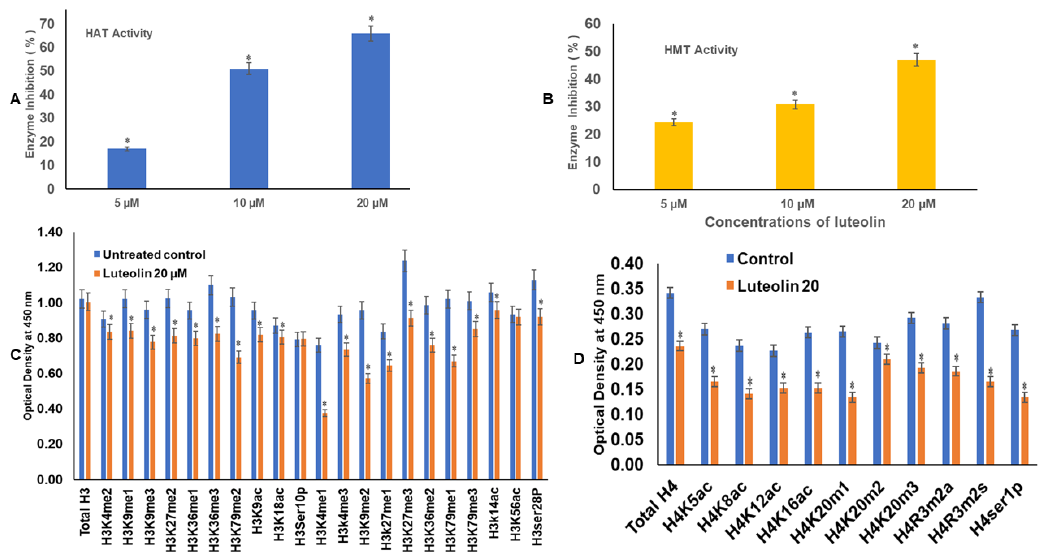
Figure 3. ( A ). Luteolin treatment of 5, 10, and 20 µM decreased the HAT activity in comparison with the untreated control. The plots were made as mean of three experiments ± SD (* represents that data is statistically significant with p ≤ 0.05). ( B ). Luteolin treatment decreased HMT H3K9 enzyme activity in HeLa cells with respect to the untreated control. The experiment was performed three times and the values were taken as mean ± SD (* represents that data is statistically significant with p ≤ 0.05) . ( C ). Luteolin 20 µM treatment for 48 h modulates the H3acetylation and methylation his- tone marks in HeLa cells, as compared with the untreated controls. ( D ). Luteolin 20 µM treatment for 48 h modulates the H4 acetylation and methylation histone marks, as compared with the un- treated controls .